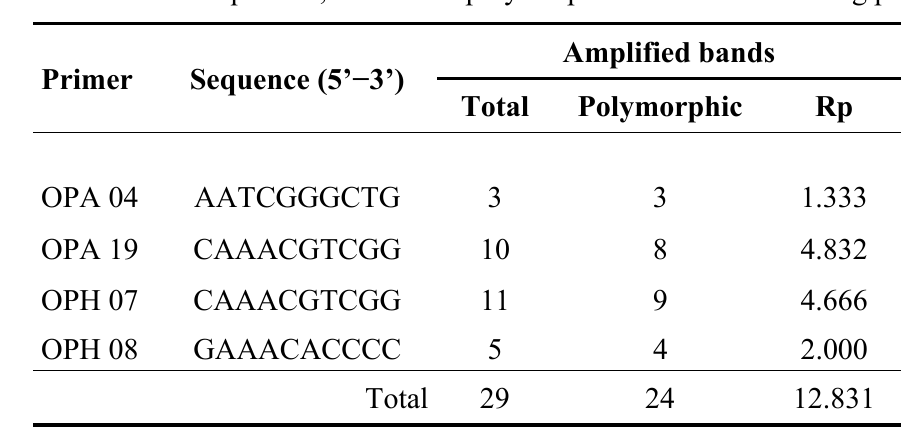
Table 1. Primers’ sequences, number of polymorphic bands and resolving power.